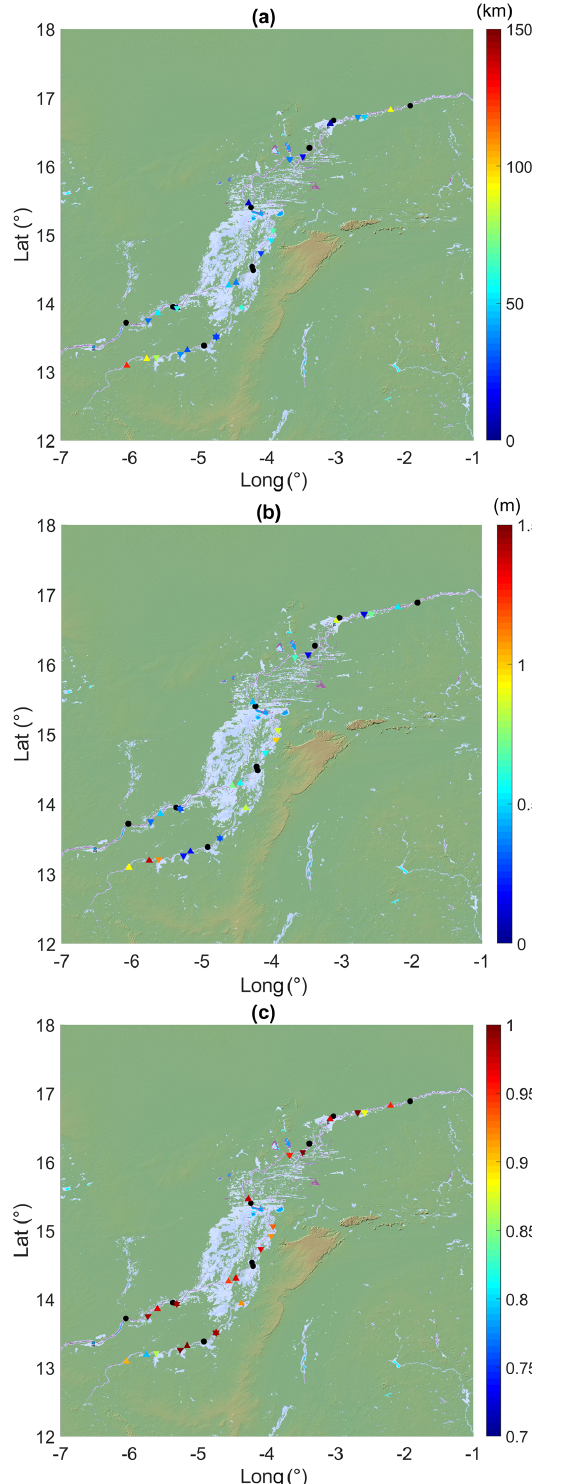
Figure 3. Comparisons between in-situ and altimetry- based wa- ter levels for Snetinel-3A (upward-pointing triangles) and 3B (downward-pointing triangles) over the IND: (a) distance between in in-situ stations and VS, (b) RMSE (m), (c)